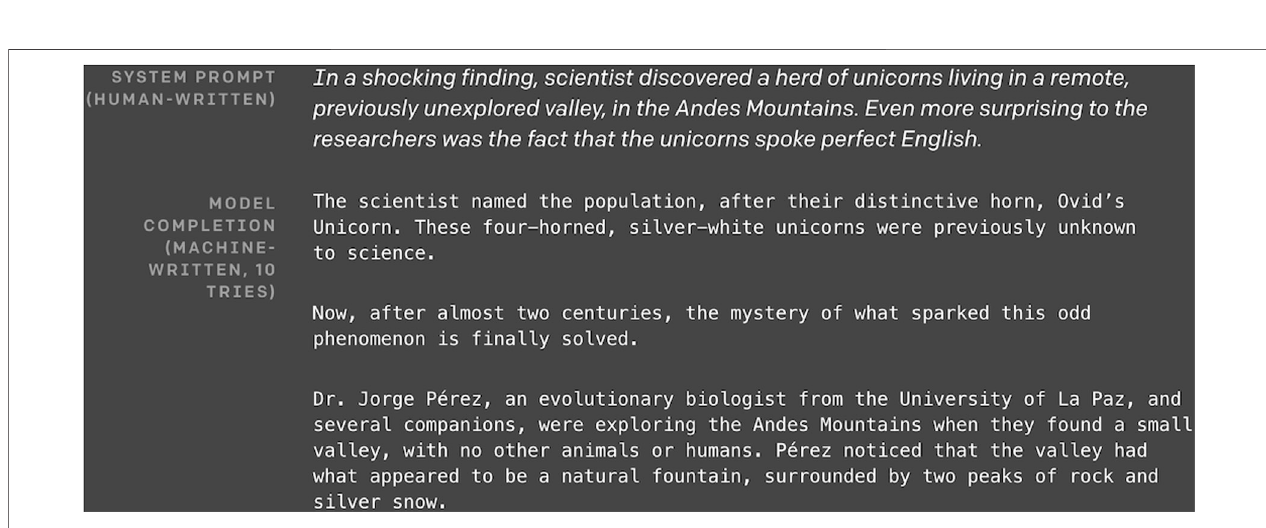
Frontiers in Big Data |